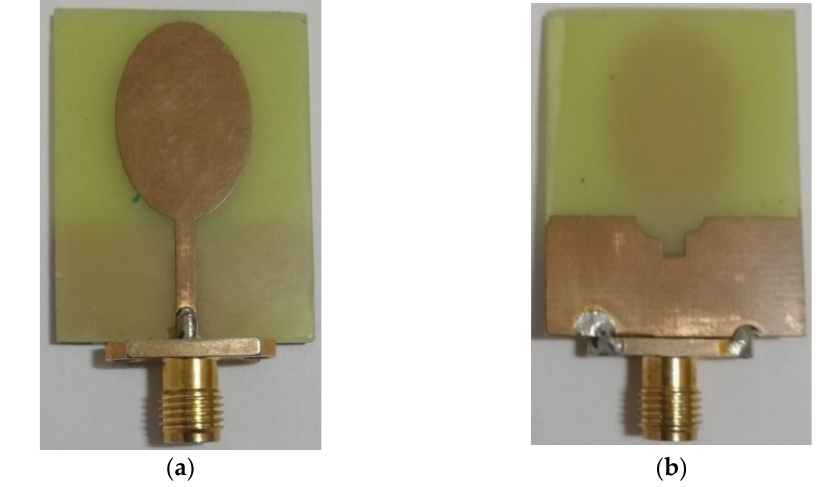
Figure 9. Suggested UWB antenna: ( a ) patch; ( b ) ground plane.